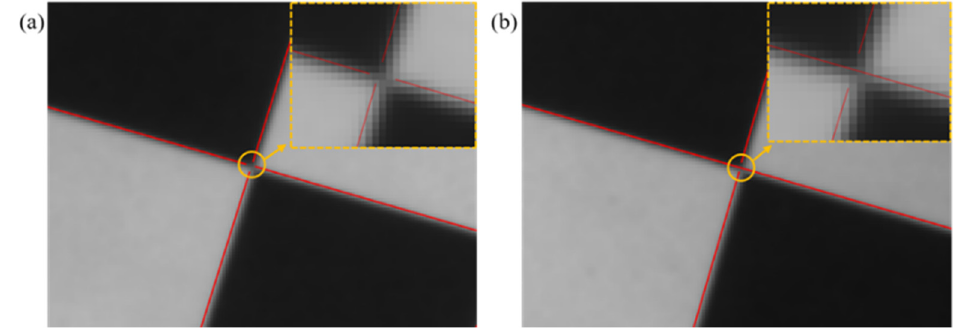
Figure 1. Effect drawing of straight-line fracture at corner: ( a ) breaking into four straight lines at the corner, ( b ) breaking into three straight lines at the corner.